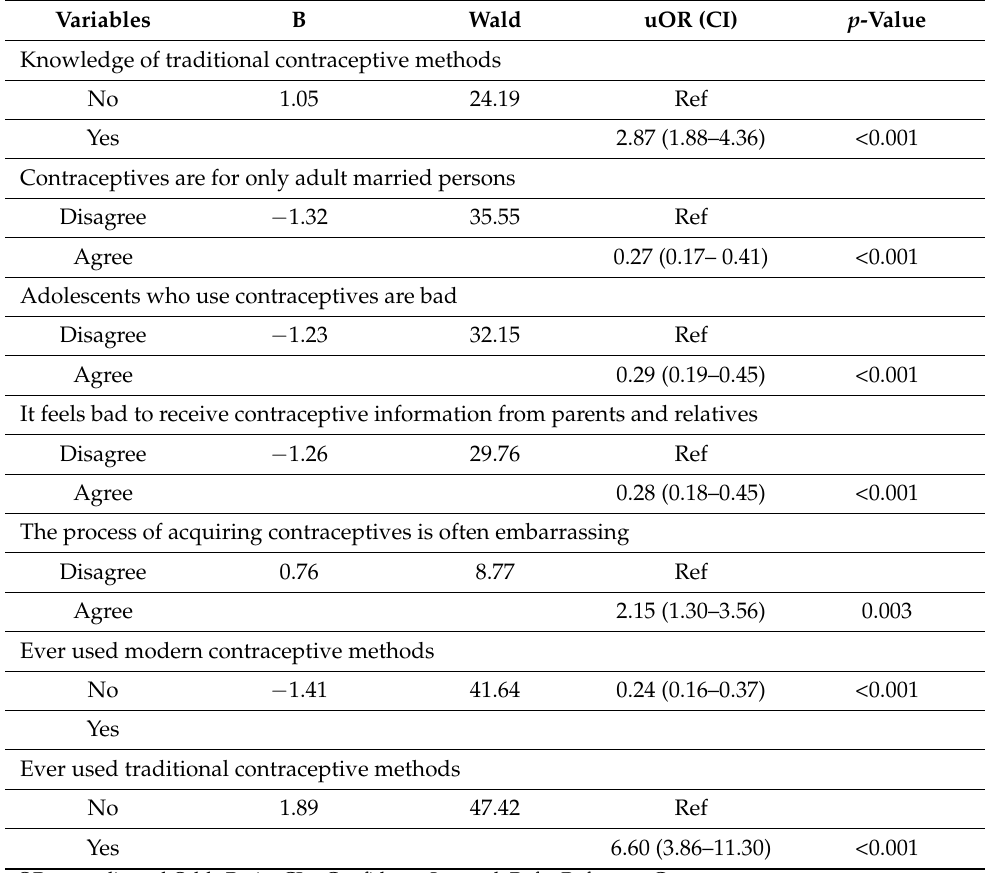
Table 2. Unadjusted Association between Adolescents’ Knowledge, Attitudes and Use of Contracep- tives on